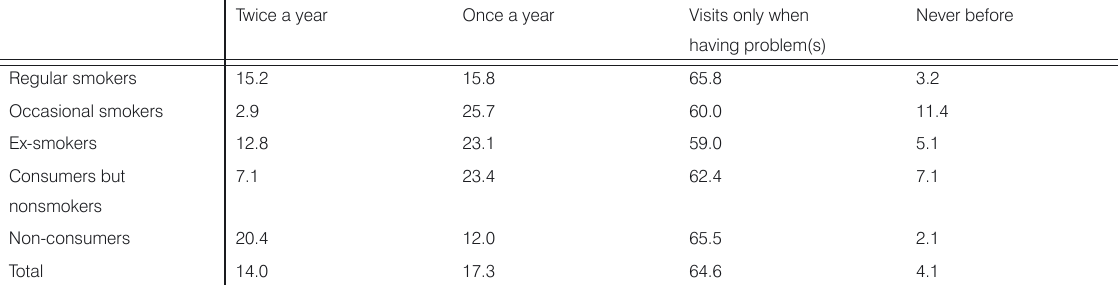
Table 3. Percentage of respondents participating in preventive dental check-ups